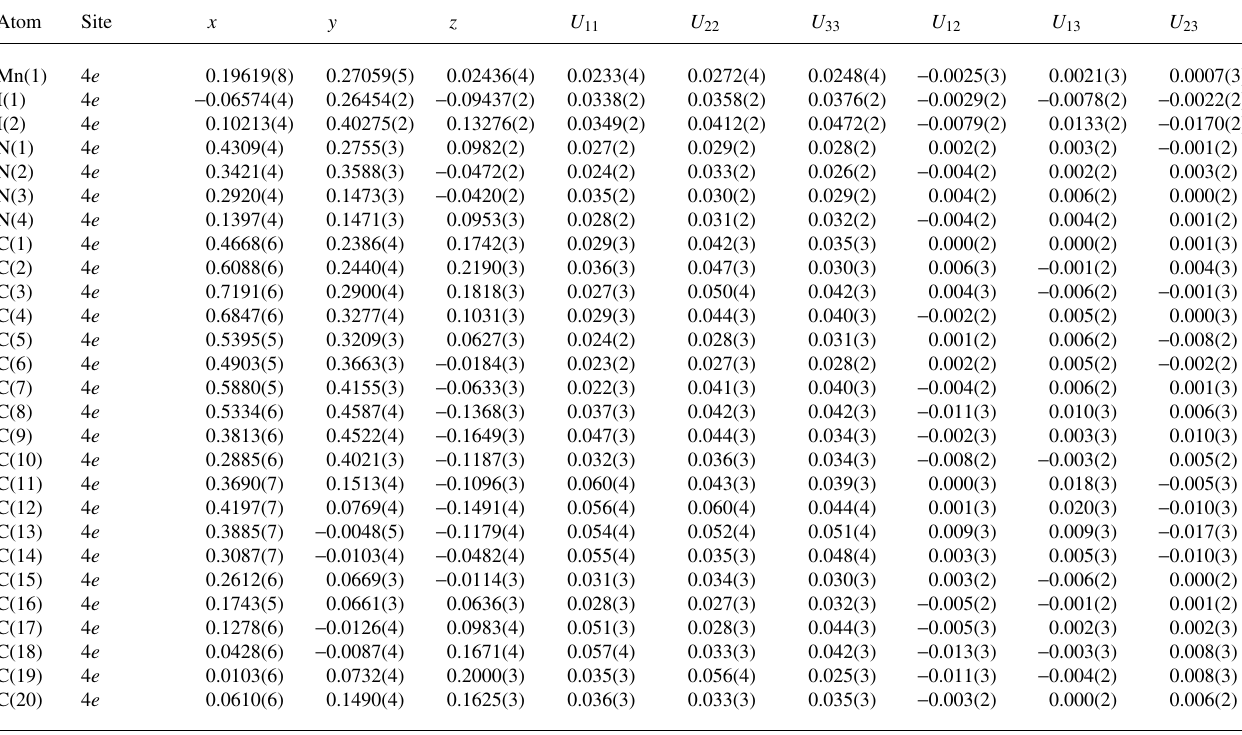
Table 3. Atomic coordinates and displacement parameters (in Å 2 )